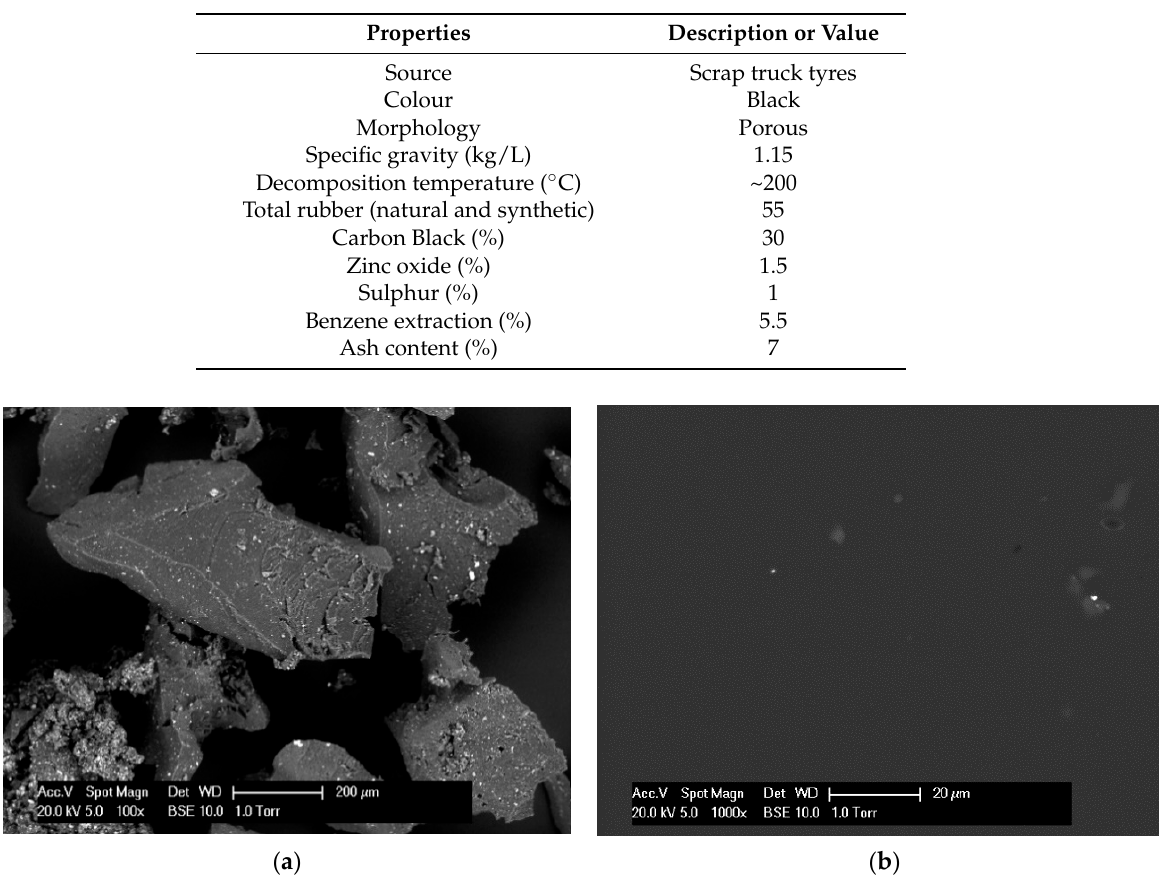
Figure 1. Environment scanning electron microscopy (ESEM) images of ( a ) CRM and ( b ) base bitumen. Table 1. Specifications of Nynas 70/100.